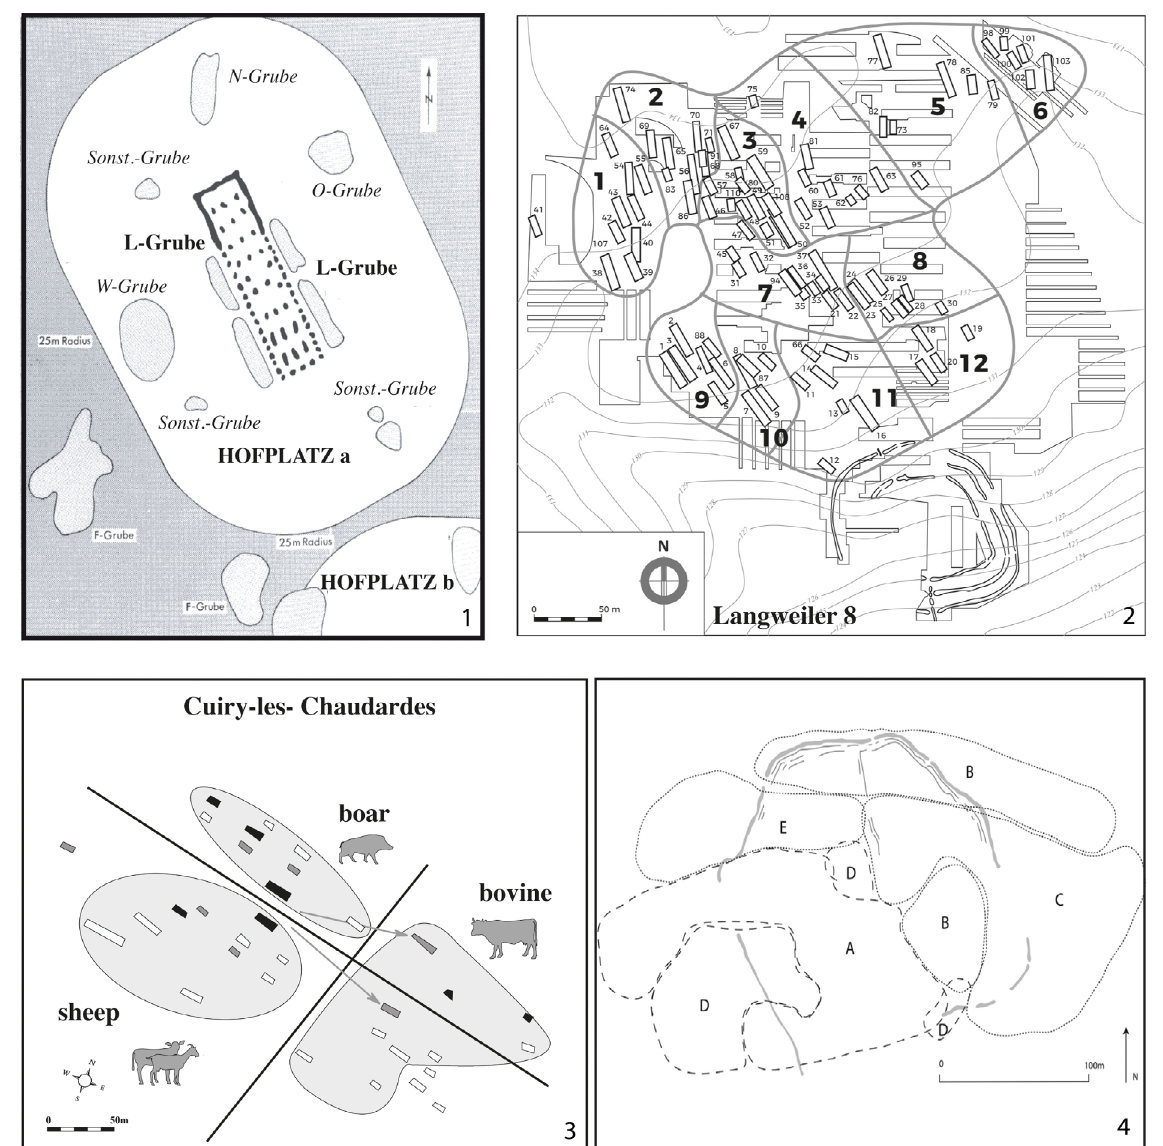
Figure 2. Household space with pits: the domestic era or Hofplatz (1) and Langweiler 8 settlement with 12 Hofplätze (2) (after Lüning 1988). Cuiry-les-Chaudardes (3) the village plan based on the fauna (Hachem 1997). Vaihingen an der Enz (4) plan showing the outline of the enclosure and palisades and the approximate extent of the clan groups and subgroupings (Bentley et al. 2013: